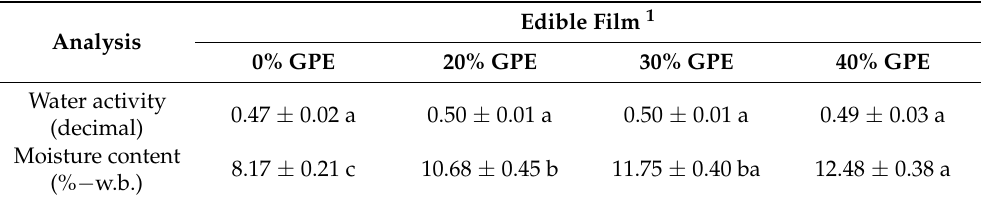
Table 2. Water activity and water content of edible films of arrowroot ( Maranta arundinacea Linn.) starch with 0, 20, 30, and 40% of grape pomace extract